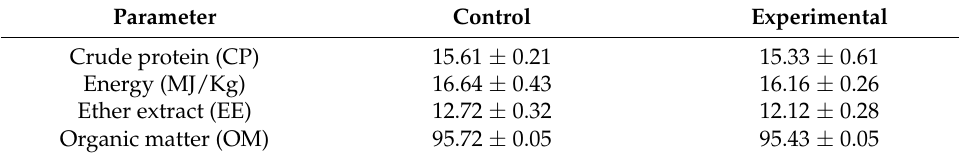
Table 2. Nutritional ingredients of concentrate supplement (%, DM).